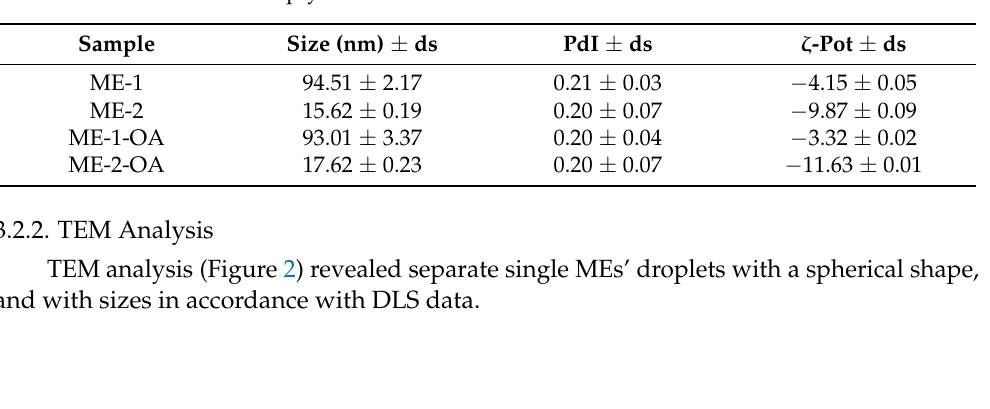
Table 3. Characteristics of empty and OA-loaded ME